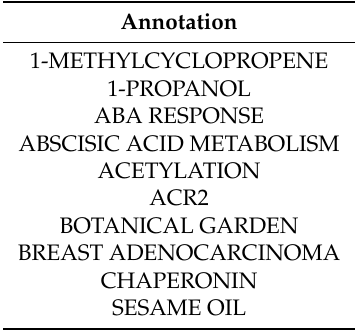
Table 2. Example of ten annotations that only appear once in the data